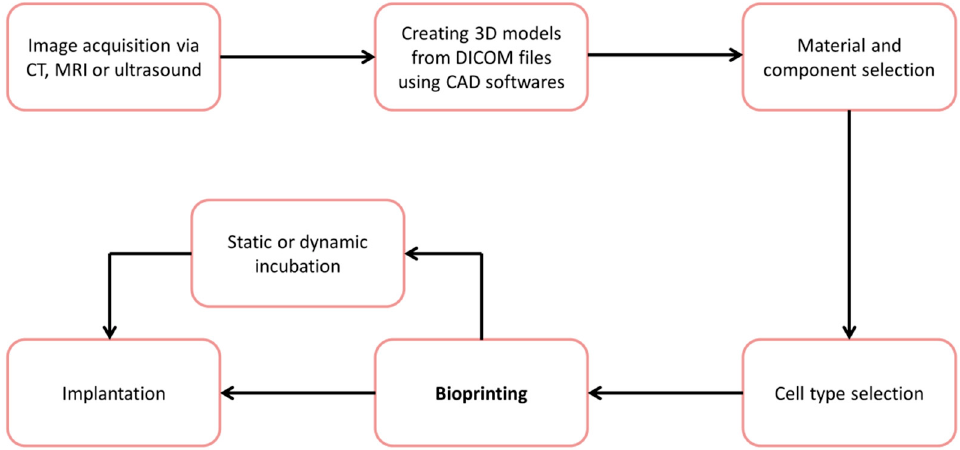
Figure 1. Schematic of Bioprinting Scaffolds for clinical use. Digital 3D images obtained from CT,